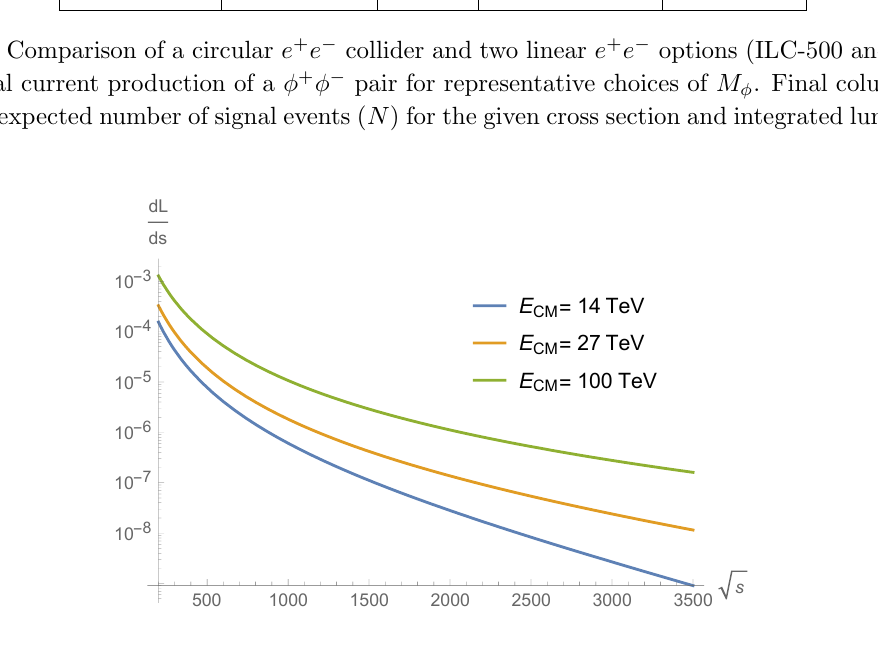
Figure 4 . Parton luminosities for charged current scalar pair production at di(cid:11)erent pp collider CM